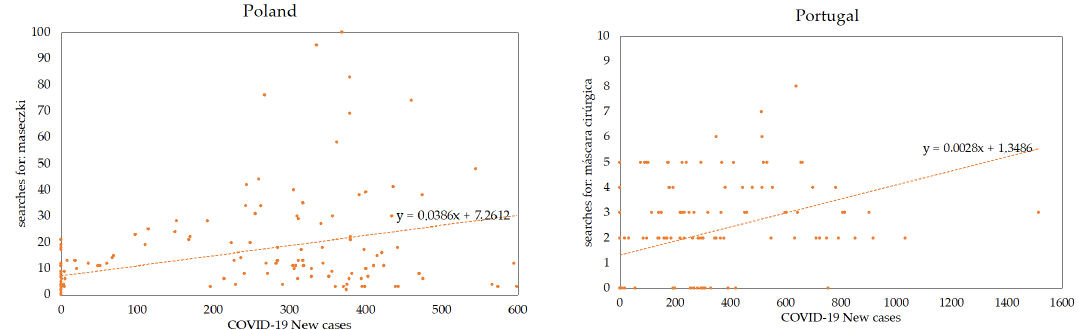
Figure 3. Scatterplots relating new cases with maseczki and máscara for Poland and Portugal, respectively.